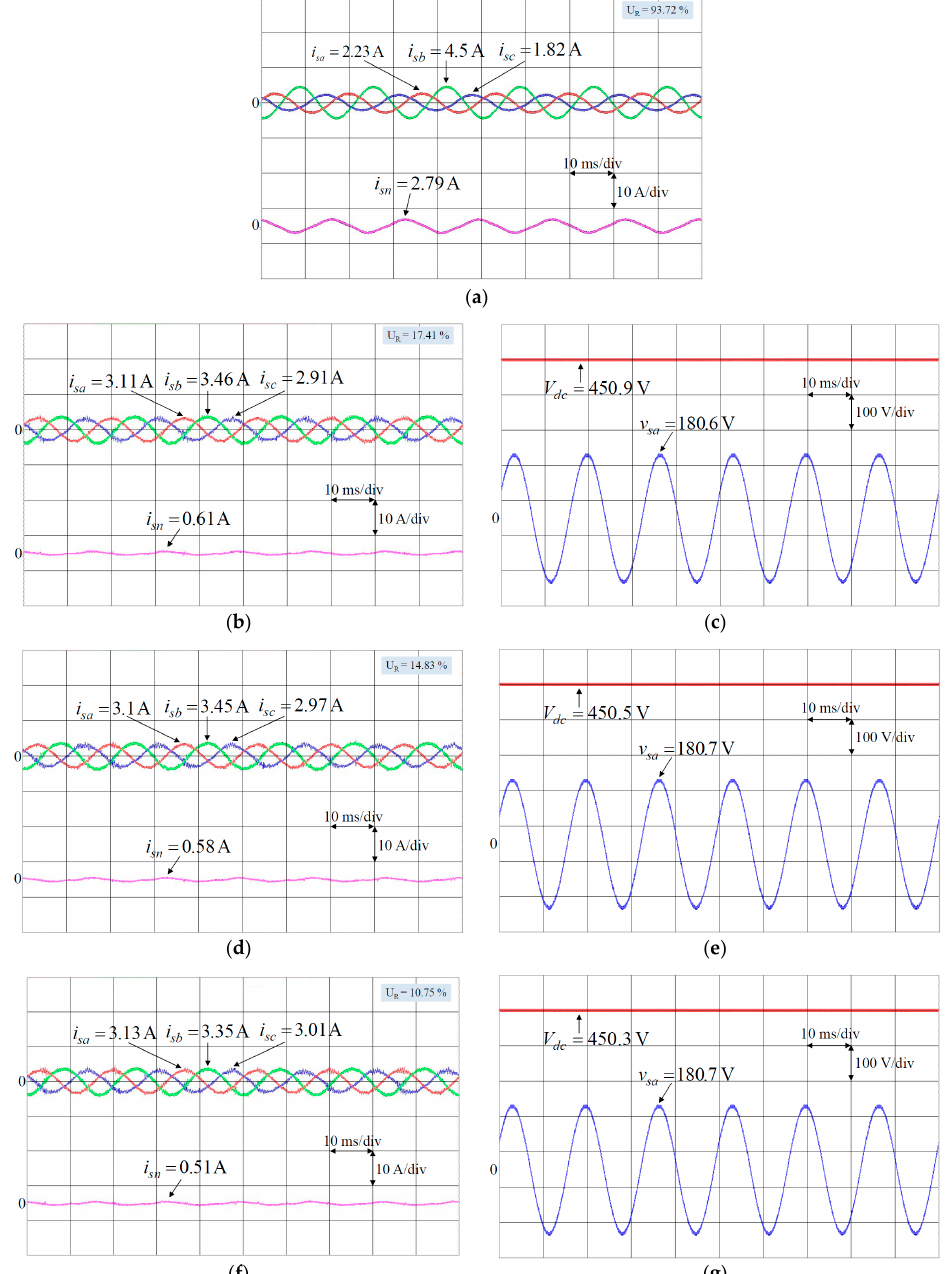
Figure 5. Experimental results at unbalanced load 1: ( a ) Responses of three-phase currents i sa , i sb , i sc and neutral current i sn without using shunt APF; ( b ) Responses of three-phase currents i sa , i sb , i sc and neutral current i sn using PI controlled shunt APF; ( c ) Responses of DC-link voltage V dc and phase voltage of power grid v sa using PI controlled shunt APF; ( d ) Responses of three-phase currents i sa , i sb , i sc and neutral current i sn using PFNN controlled shunt APF; ( e ) Responses of DC-link voltage V dc and phase voltage of power grid v sa using PFNN controlled shunt APF; ( f ) Responses of three-phase currents i sa , i sb , i sc and neutral current i sn using proposed PPFNN controlled shunt APF; and ( g ) Responses of DC-link voltage V dc and phase voltage of power grid v sa using proposed PPFNN controlled shunt